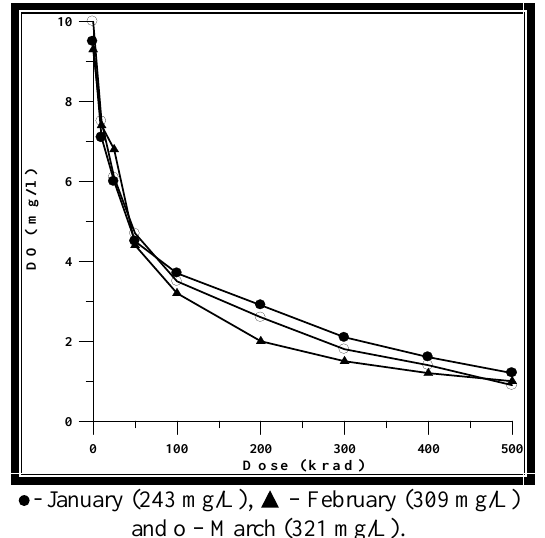
Figure 5: DO values of irradiated samples of wastewater for BOD